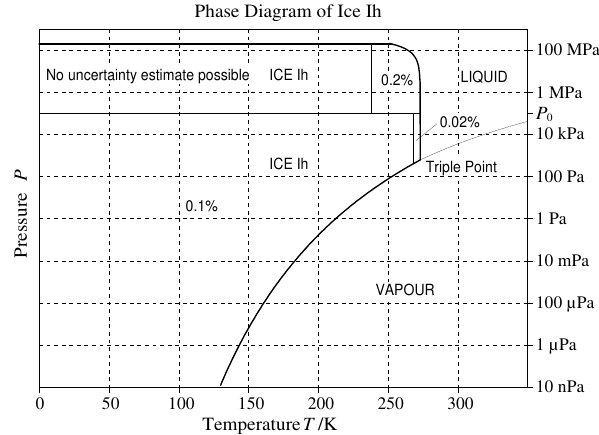
Fig. 2: Range of validity (bold curves) of the Gibbs function of ice Ih and uncertainty Fig. 2. Range of validity (bold curves) of the Gibbs function of ice of density. Ih and uncertainty of 2.3 Sea Salt Dissolved in Water The Gibbs function ( ) PTSg ,, ASW of seawater (IAPWS, 2008a; Feistel, 2008) is expressed as the sum of a Gibbs function for pure water, ( ) PTg , W , numerically available from the IAPWS-95 formulation, and a saline part, ( ) PTSg ,, AS : (2.1) Here, salinity is expressed as Absolute Salinity S A , the mass fraction of dissolved salt in seawater, which for standard seawater equals the Reference-Composition Salinity within experimental uncertainty (Millero et al., 2008; Wright et al., 2010b). In representing the properties of Standard Seawater, the range of validity of the Gibbs function for seawater is shown in Fig. 3. For temperatures in the oceanographic standard range, salinities up to 40 g/kg are properly described up to 100 MPa. For higher salinities up to 120 g/kg and temperatures up to 80 °C, the application is restricted to atmospheric pressure (101 325 Pa). Up to saturation, the salinity of cold concentrated brines agrees well with Antarctic sea-ice data (Fig. 6). For hot concentrates (region F in Fig. 3) the partial derivatives of density are not reliable. New density measurements (Millero and Huang, 2009; Safarov et al., 2009) have led to some recent improvements and an option to use an extension introduced